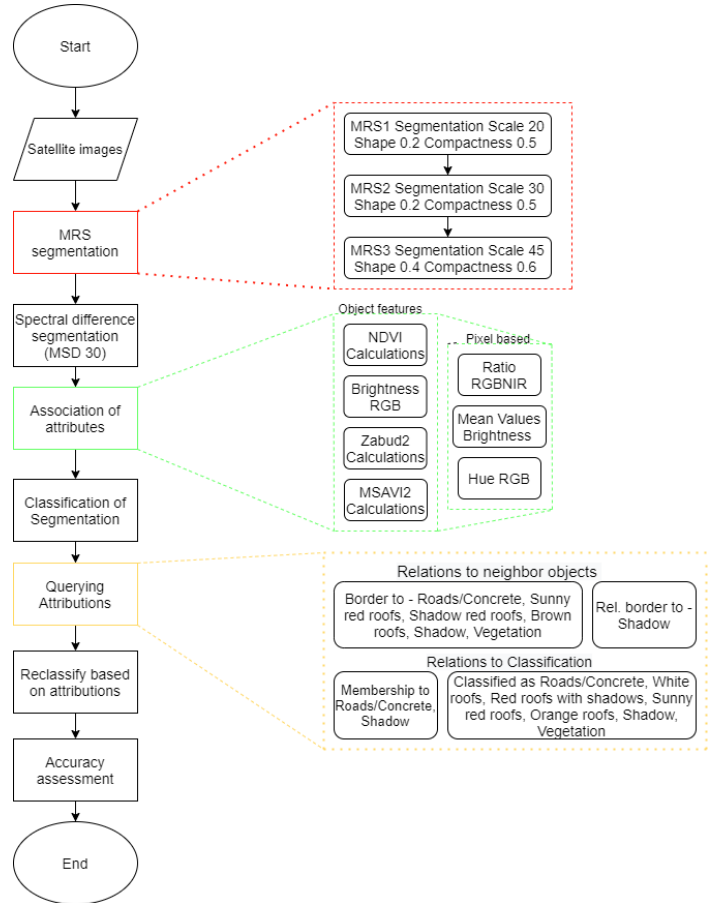
Figure 4. Extracting footprints of buildings using